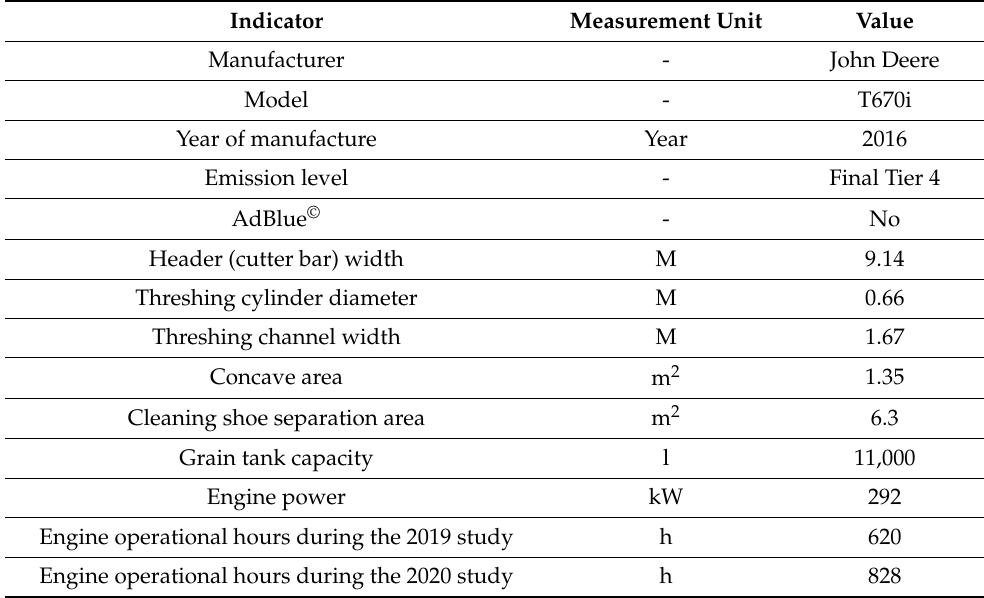
Table 3. Combine harvester